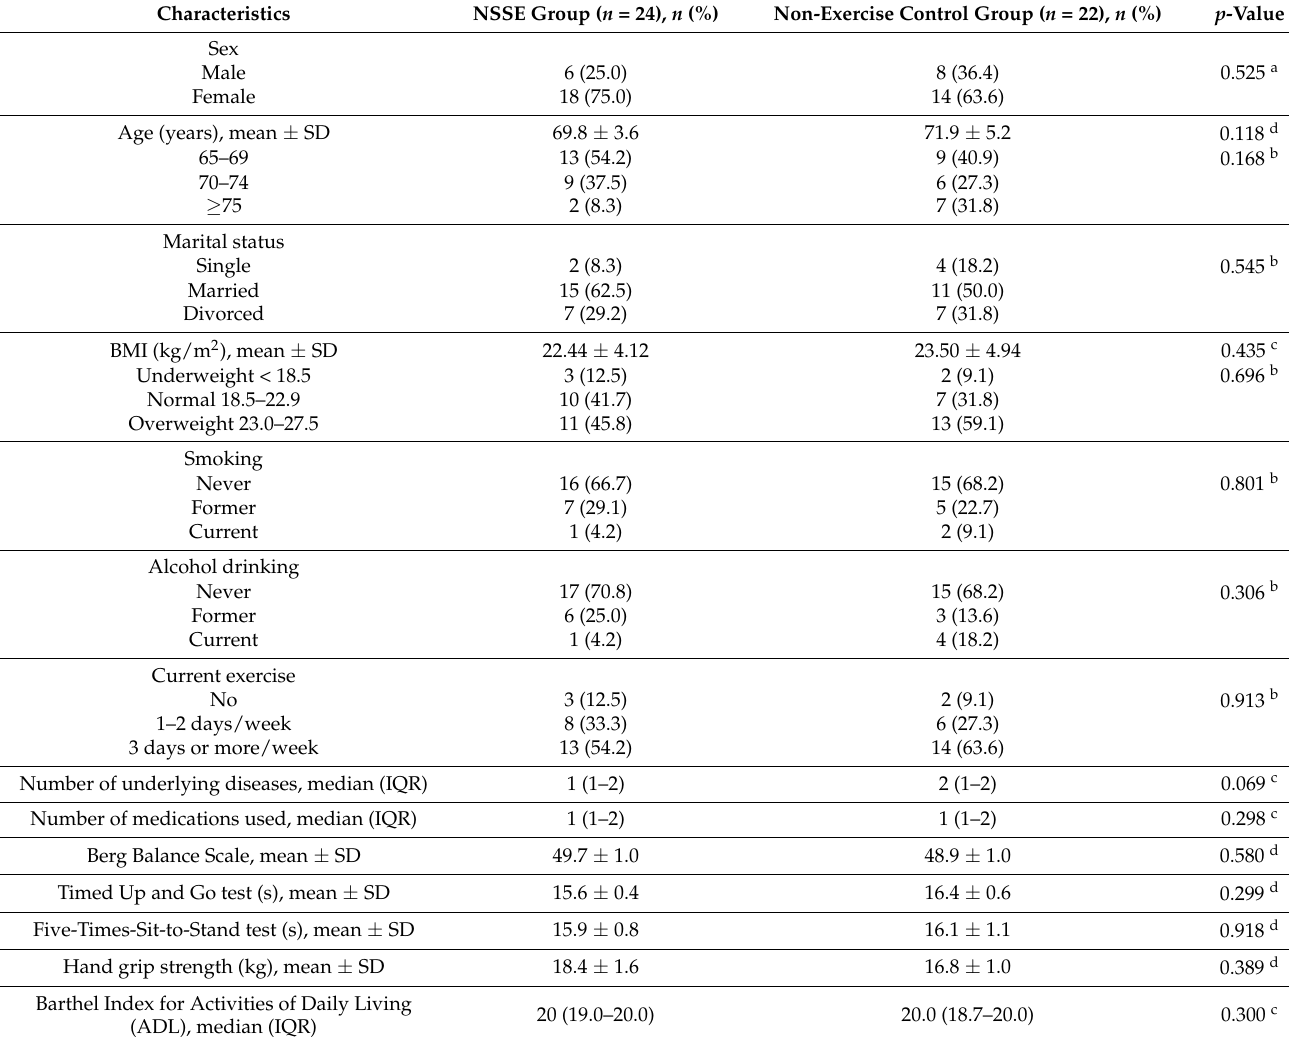
Table 1. Baseline descriptive data of the